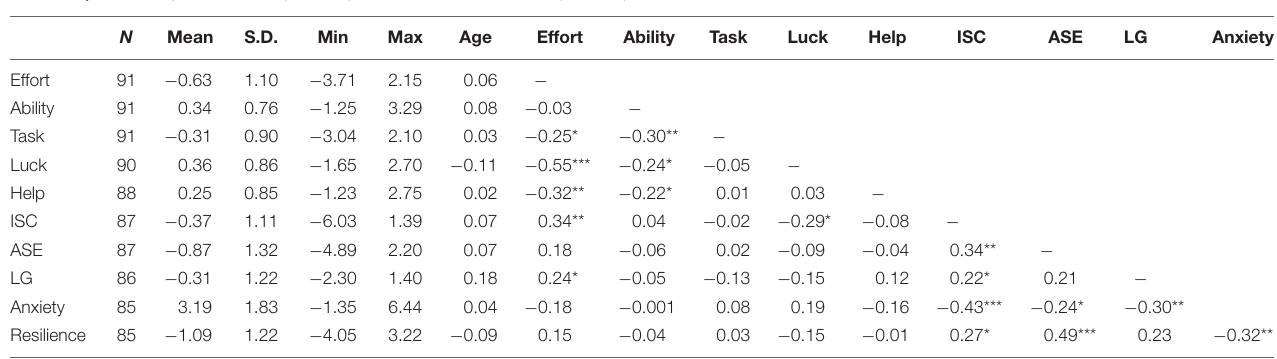
TABLE 3 | LA: Descriptive statistics ( N = 101) and zero-order correlation